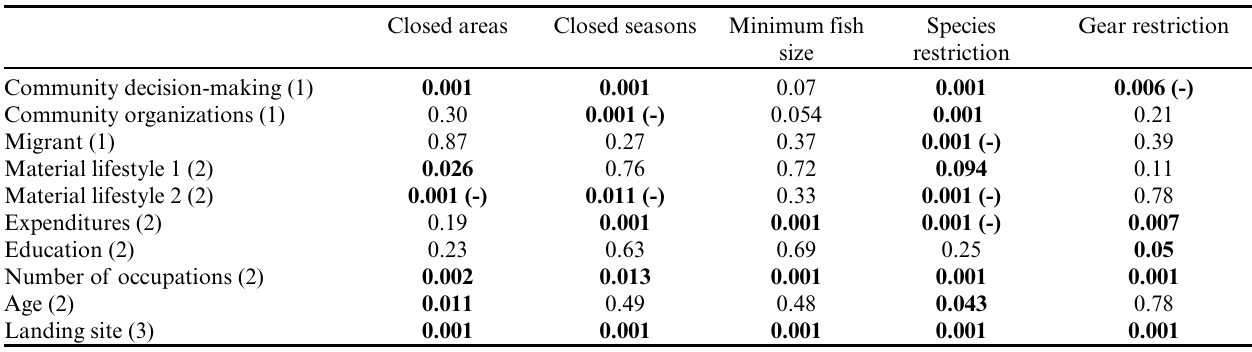
Table 6. Levels of significance† for the relationships between socioeconomic factors and perceived benefits to self for different management options based on principal components